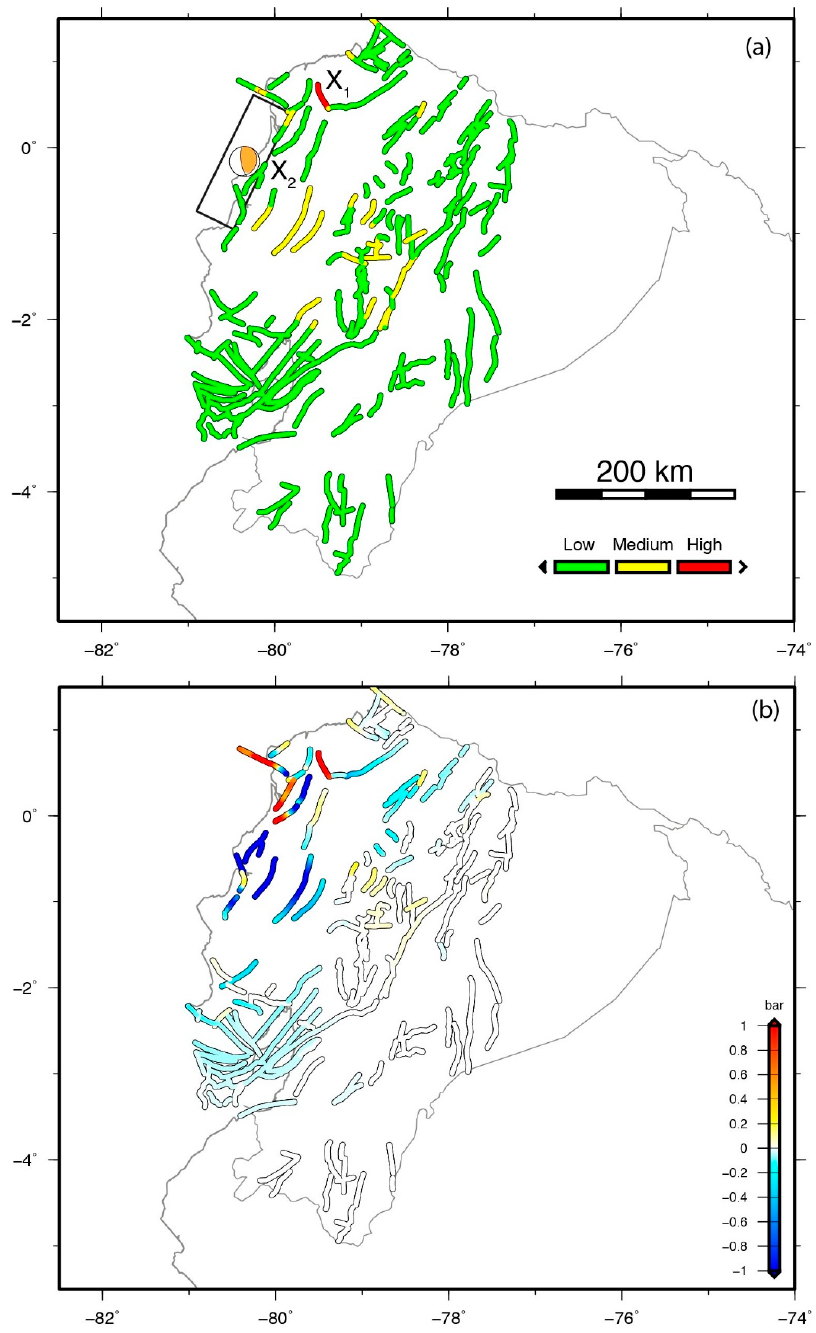
Figure 10. ( a ) Map of potentially activated mapped faults calculated using the earthquake source from the Global CMT focal mechanism. The black rectangle delineates the source model. Faults labelled X 1 and X 2 are discussed in Section 5.1; ( b ) Difference of Coulomb stress change on mapped faults. This map results from the difference between map in Figure 7a and map in Figure 10a.